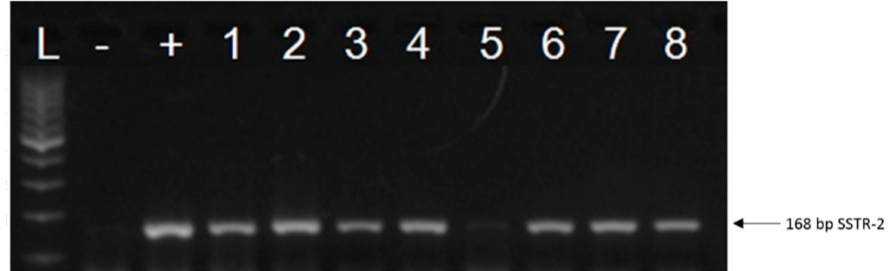
Figure 1. A representative figure of the expression of SSTR-2 in human uveal melanoma. L: 100 bp DNA Ladder; “ − ”: negative control; “+”: positive control (UM pool); 1–5: representative human uveal melanoma tissue samples; 6: CACO-2 cell line; 7: OCM-1 human uveal melanoma cell line; 8: OCM-3 human uveal melanoma cell line.